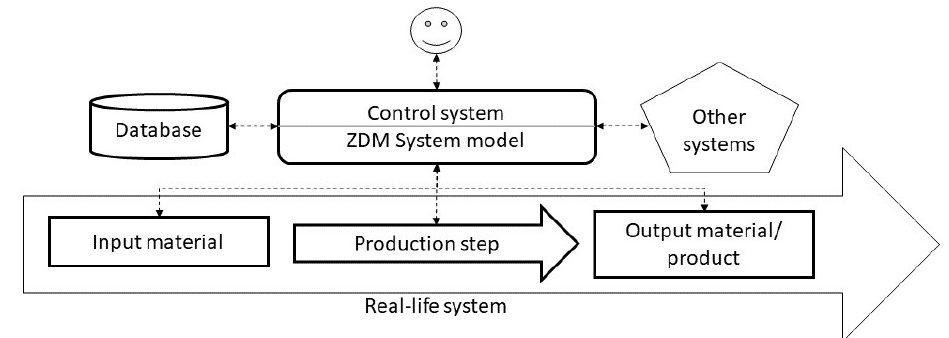
Figure 1. Diagram showing information flow in a generic production process step with an integrated control